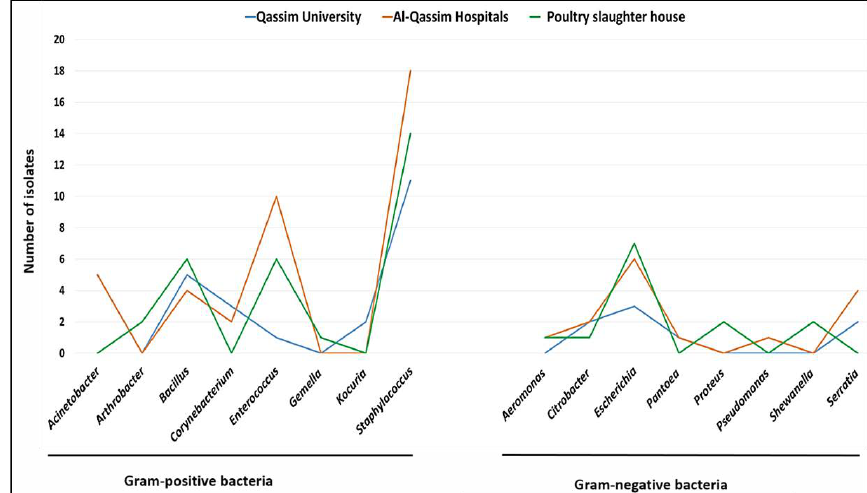
Fig. 1. Genera of gram-positive and negative airborne bacteria recovered from three different localities in Al-Qassim